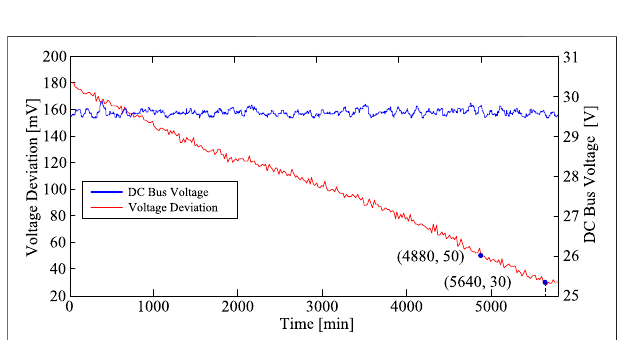
FIGURE9| Terminal voltages ofsixcellsduring thedischarging process with a static acceleration coef fi cient.